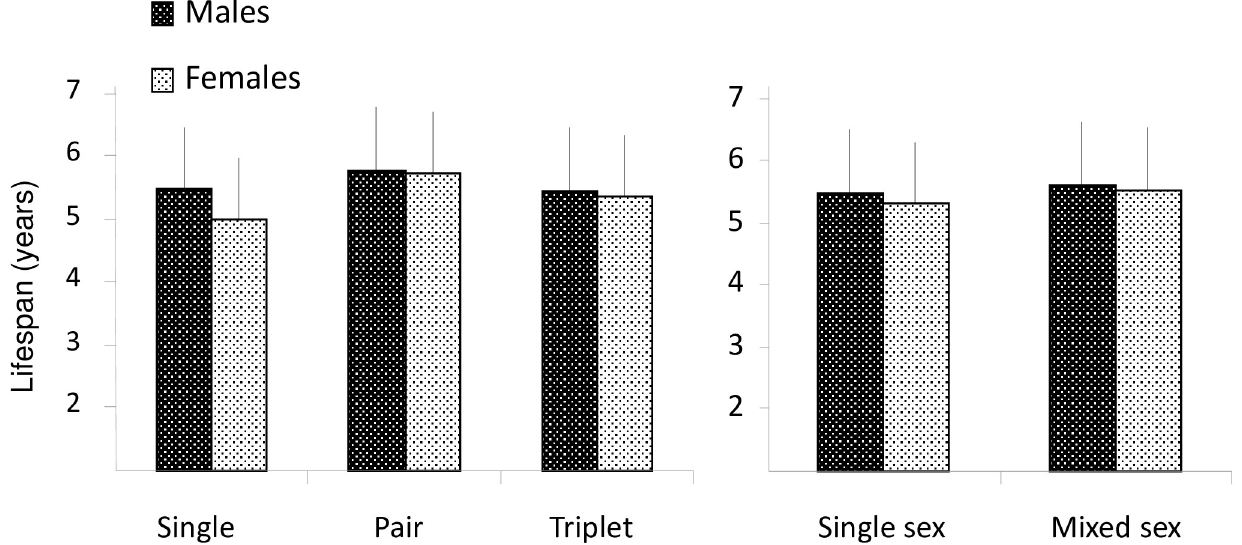
Fig 1. Lifespan (means ± SEM in years) in female and male offspring according to the size (left panel) and the type (right panel) of the litters.